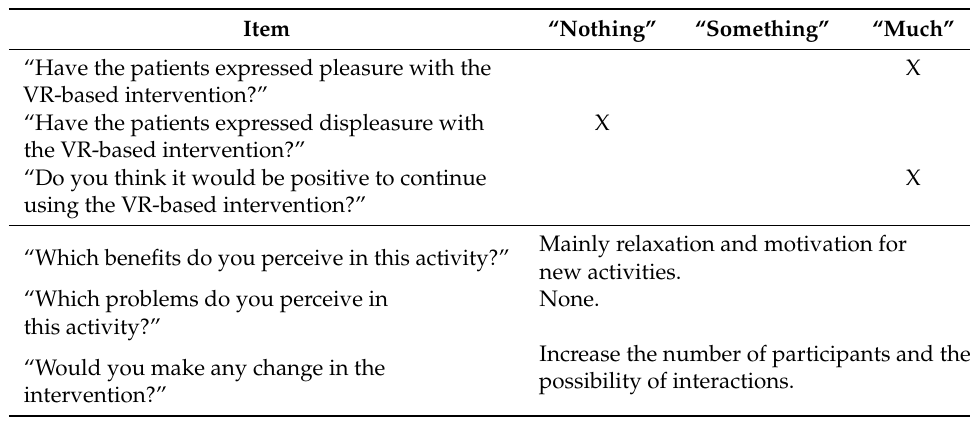
Table 7. Neuropsychologists’ feedback about the iVR-based